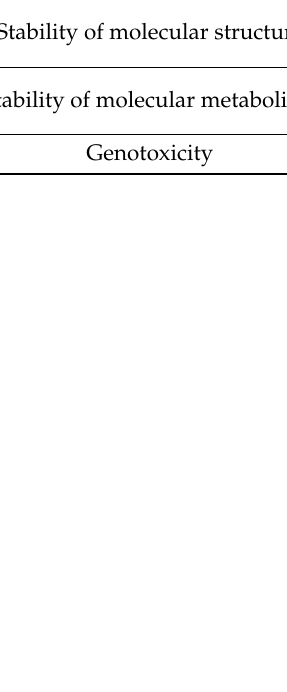
Table 7. Evaluation criteria for the functional evaluation parameters of stability and genotoxicity.